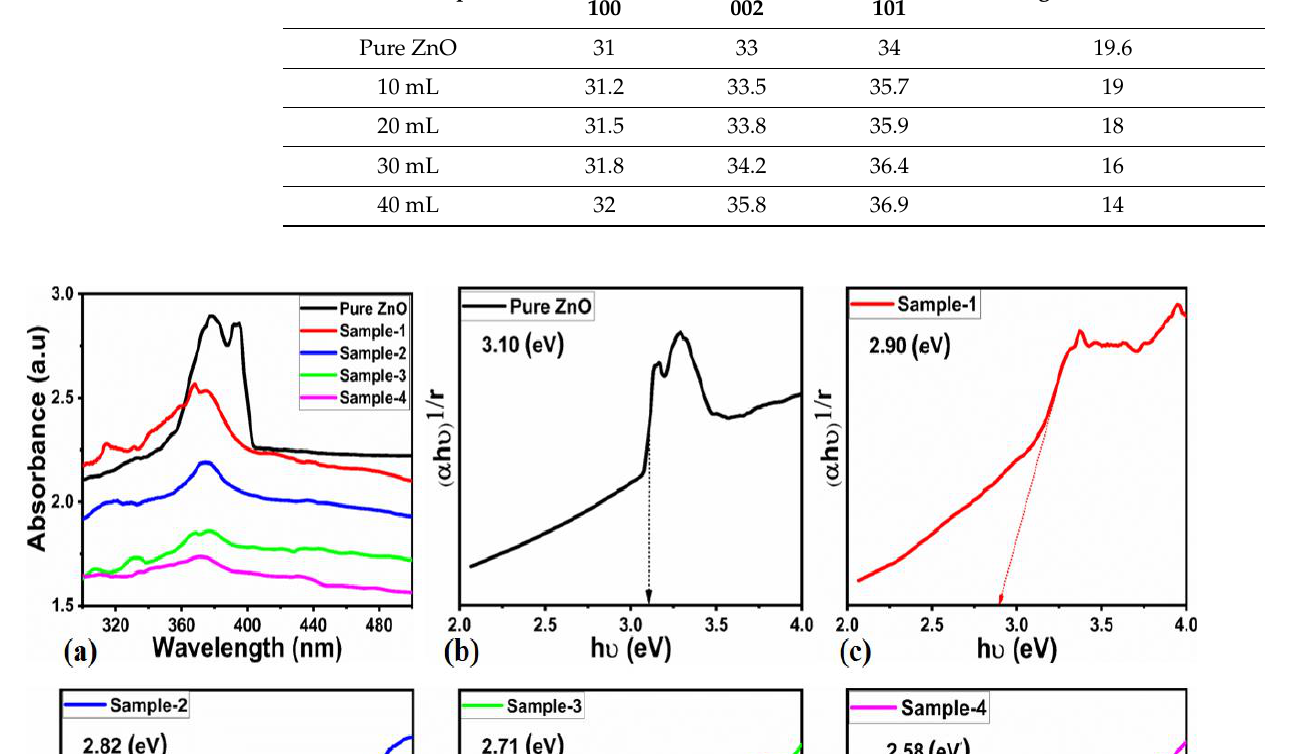
Table 1. Calculated average crystallite size (nm) for pure ZnO and green synthesized ZnO samples prepared in the presence of various amounts of leaf extract of S. oleracea .